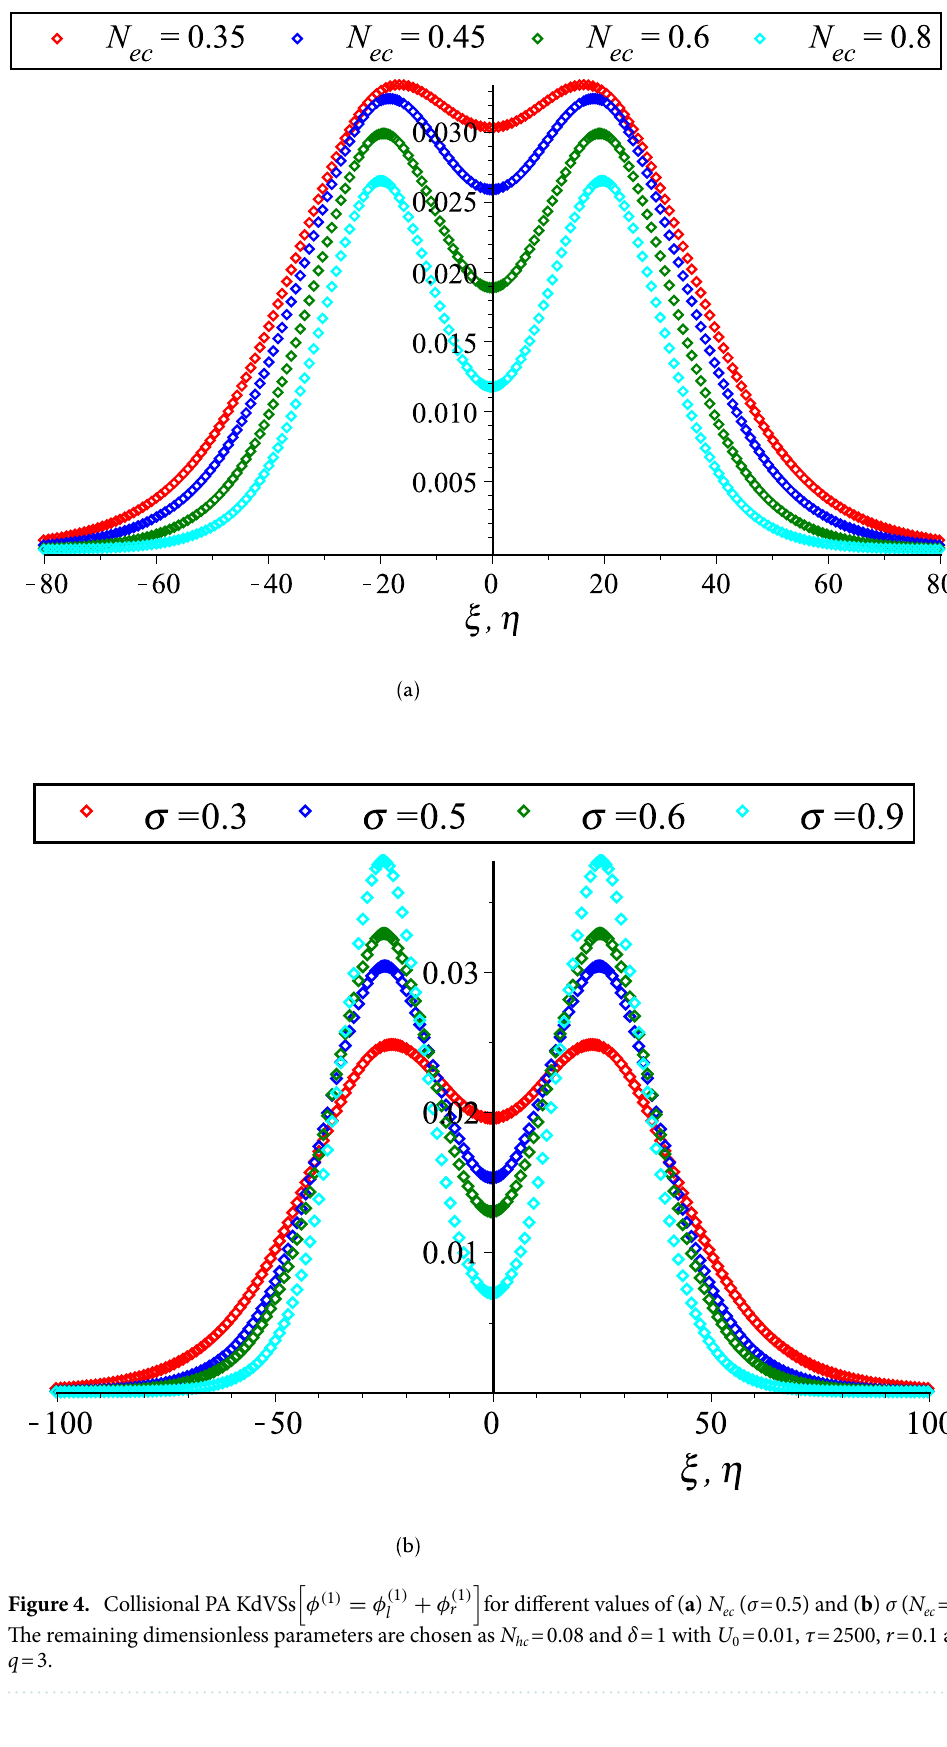
Figure 4. Collisional PA KdVSs The remaining dimensionless parameters are chosen as N hc = 0.08 and δ = 1 with U 0 = 0.01, τ = 2500, r = 0.1 and q =